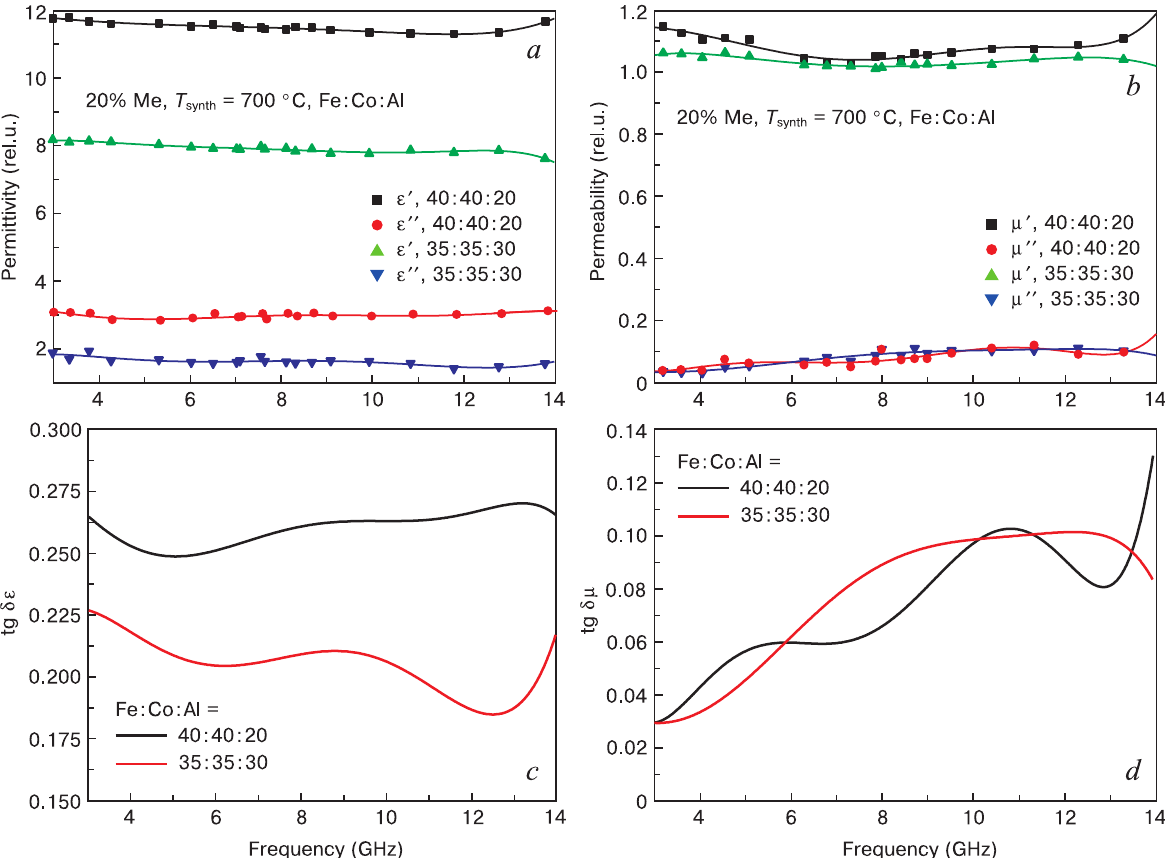
Figure 8. Frequency dependences of ( a ) complex permittivity and ( b ) permeability and tangents of ( c ) dielectric and ( d ) magnetic loss for different metal ratios in